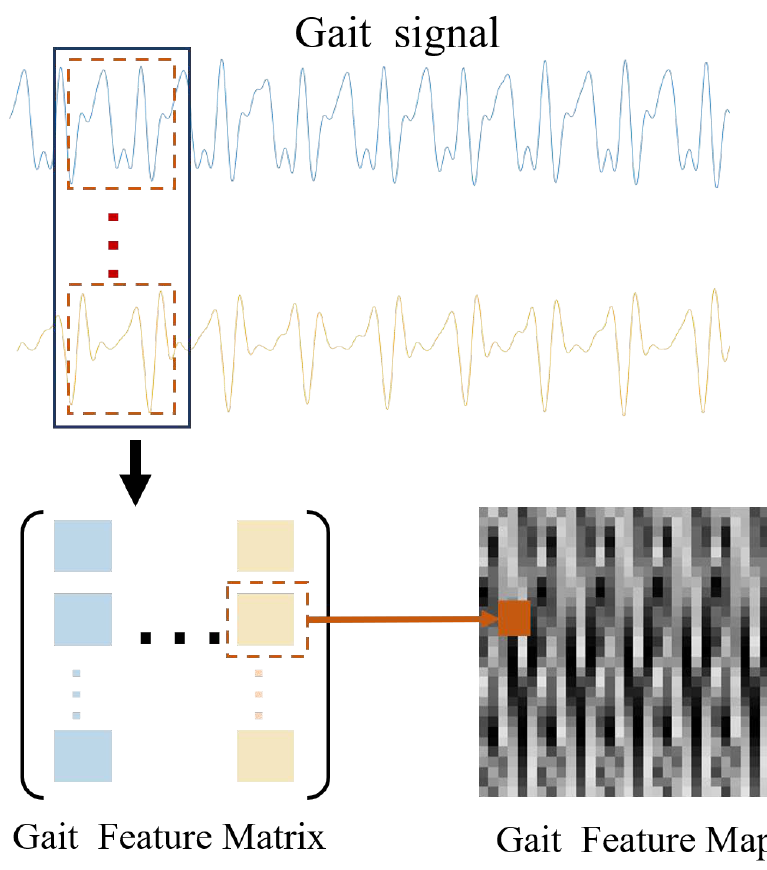
Figure 9. The process of